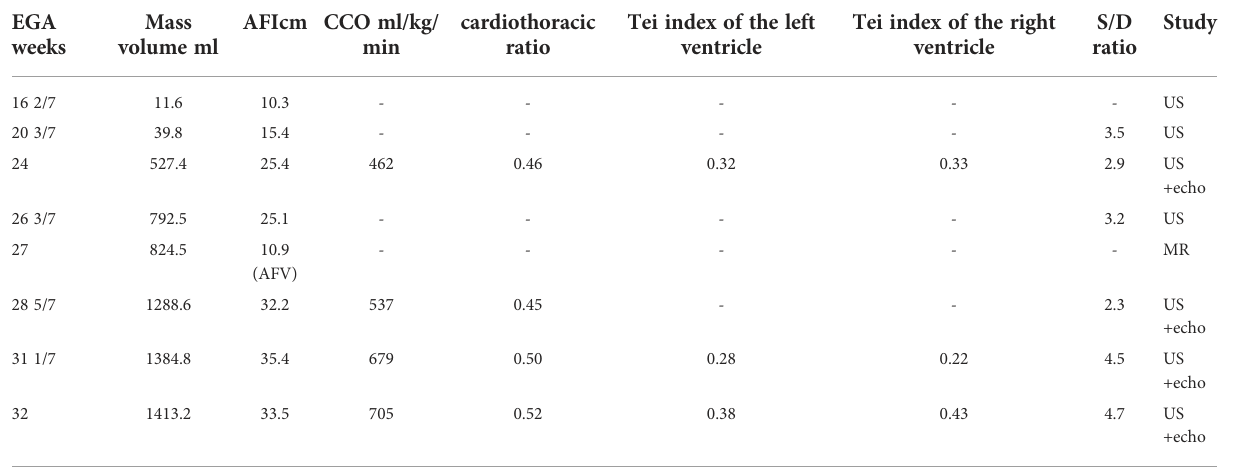
TABLE 1 Measurements in the